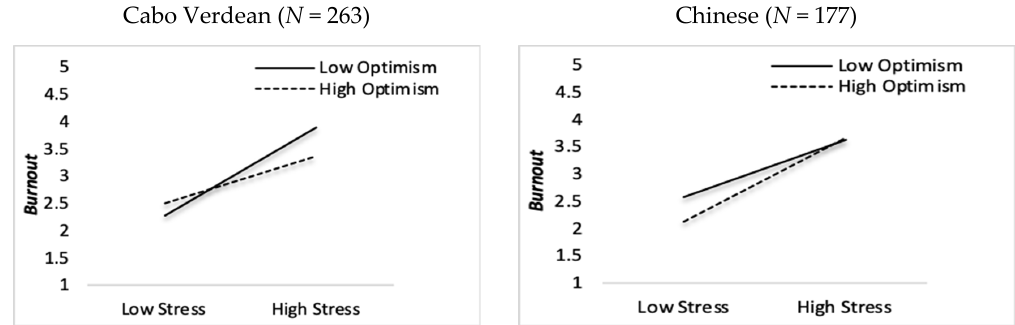
Figure 3. Graphic representation of the interaction between occupational stress and optimism in predicting employee job burnout.